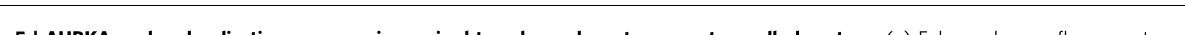
Figure 5 | AURKA nuclear localization sequence is required to enhance breast cancer stem cell phenotype. ( a ) Enhanced green fluorescent protein (EGFP)-fused truncated forms of AURKA were transfected into 293T cells for 24h. The localization of EGFP-fused truncated forms of AURKA were analysed via confocal microscopy. Scale bar, 25 m m. ( b ) DsRed-fused 333–383 region of AURKA was transfected into 293Tcells for 24h. The localization of DsRed-fused 333–383 region of AURKA was analysed by confocal microscopy. Scale bar, 25 m m. ( c , d ) MDA-MB-231 cells were co-infected with lentivirus expressing AURKA shRNA (shAURKA/sh Control) and the truncated protein (1–383 or 1–333). Puromycin (1 m gml (cid:3) 1 ) and blasticidin (5 m gml (cid:3) 1 ) selected cells were subjected to immunoblotting (IB) analysis ( c ) or CD24 low /CD44 high population analysis via flow cytometry ( d ). ( e ) The cells in c were subjected to mammospheres culture assay for 6 days. The left panel shows the distribution pattern according to mammosphere size (Kruskal–Wallis test followed by Dunn’s multiple comparison test, *** P o 0.001). The right panel showed the number of F4 60 m m mammospheres. ( f ) AURKA (1–333) was fused with ER via a nuclear localization sequence to generate ER-NLS-AUR333 fusion protein (upper panel). MDA-MB-231 cells were co-infected with lentivirus expressing AURKA shRNA (shAURKA/sh Control) and the fusion protein (ER-NLS-AUR333). The cells were then cultured in fresh medium for 48h in the presence or absence of 200nM OHT. Puromycin (1 m gml (cid:3) 1 ) and blasticidin (5 m gml (cid:3) 1 ) selected cells were harvested for CD24/CD44 staining and analysis via flow cytometry (lower panel). ( g ) The cells in f were cultured in mammosphere medium with or without 200nM OHT. The cells were then photographed and quantified at the end of the first-round mammosphere culture (6 days) and the secondary passaging (additional 6 days). The left panel shows the distribution pattern of mammosphere size from MDA-MB-231 (Kruskal–Wallis test followed by Dunn’s multiple comparison test, *** P o 0.001). The right panel shows the number of mammosphere ( F4 60 m m). Data were presented as the means ± s.e.m. of three independent experiments (analysis of variance (ANOVA) followed by least significant difference (LSD) test; * P o 0.05; ** P o 0.01; *** P o